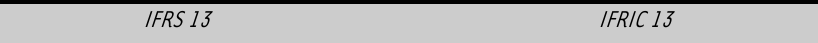
TABLE 5: IFRS 13 and IFRIC 13’s similar guidelines on determining the fair value of a liability (deferred revenue) IFRS 13 IFRIC 13 When a quoted price for the transfer of an identical If there is not a quoted market price for an identical point, fair value must be measured or a similar liability is not available and the identical item is held by another party as an asset, using another valuation technique. The an entity shall measure the fair value of the liability supplier may measure the fair value of points by reference to the fair value of the benefits from the perspective of a market participant that they could be exchanged for (AG, paragraph holds the identical item as an asset at the 1). In other words, the value of the points measurement date (paragraph 37). (held as an asset) in the hands of the